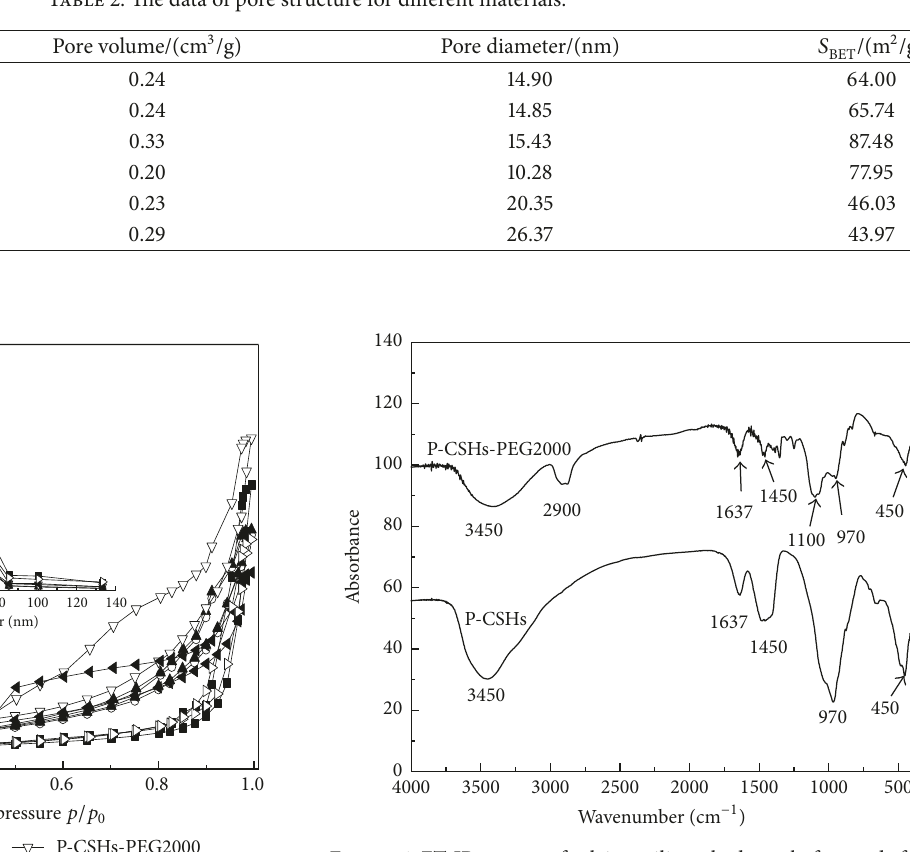
Figure 4: FT-IR spectra of calcium silicate hydrates before and after